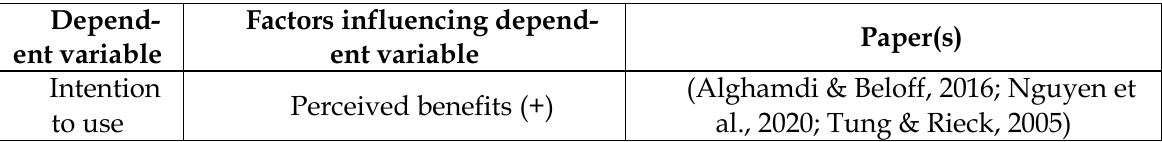
Table 11: Main factors influencing the usage of e-government services by businesses.